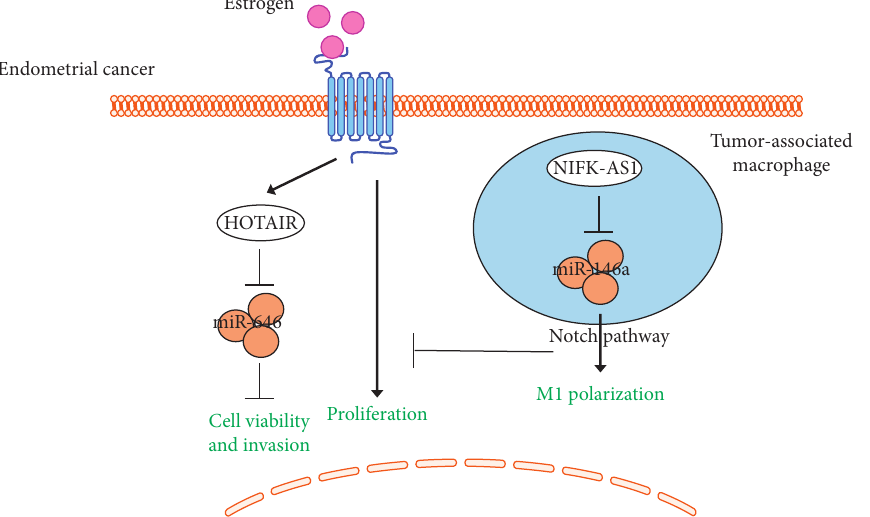
Figure 4: The interaction of lncRNAs and estrogen in endometrial cancer. Two lncRNAs, HOTAIR and NIFK-AS1, have been reported to interact with estrogen and its receptor in endometrial cancer via miRNA sponging. Solid arrow: induction; flat-ended arrow: